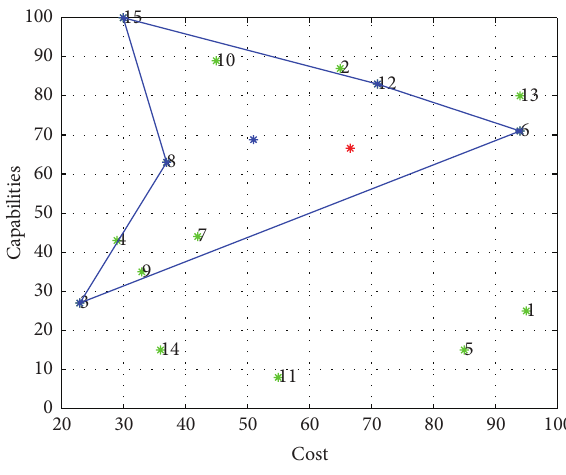
Figure 9: Result of the team